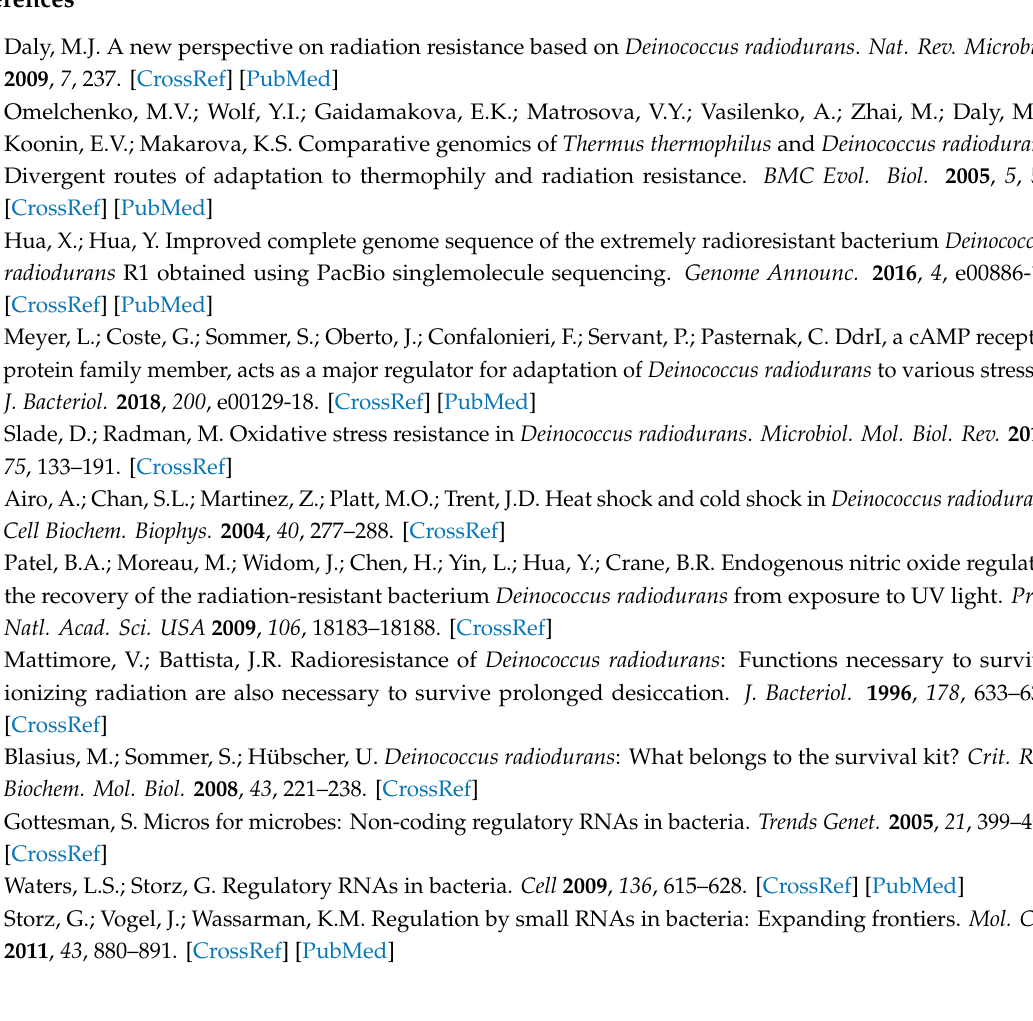
Table S1: Primers used in this study; Table S2: Synthesized ssRNA oligonucleotide derivatives for MST; Table S3: List of genes di ff erentially expressed in the dsr11 deletion mutant compared to the WT strain; Table S4: The possible targets of dsr11 predicted by